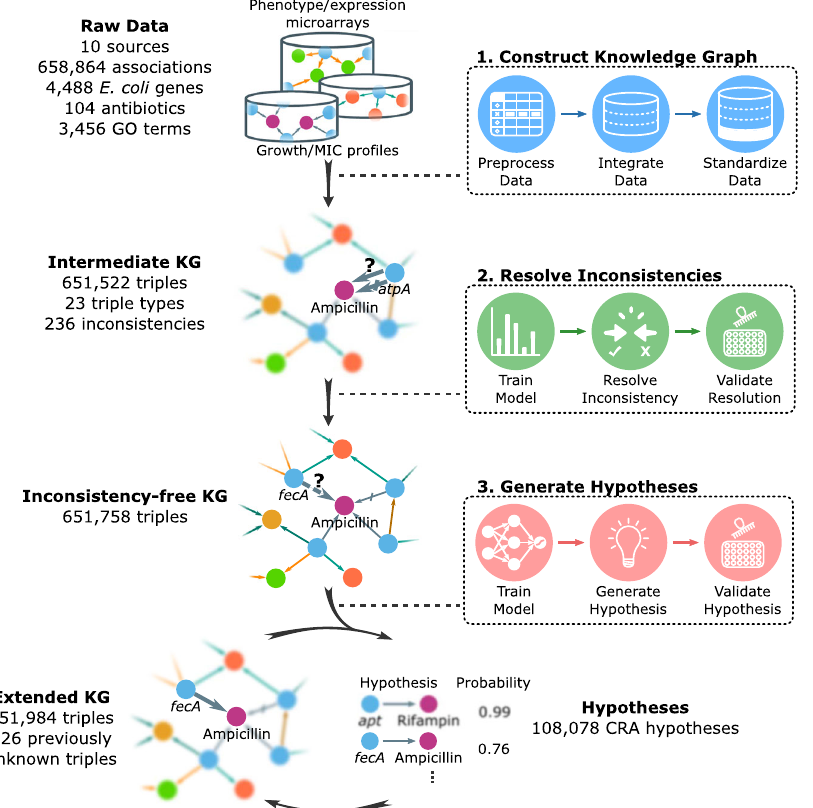
Fig. 1 Overview of the KIDS framework. First, an intermediate knowledge graph is created from ten sources by processing RDF triples that encode 23 types of associations. Second, inconsistencies are computationally resolved and experimentally validated to construct an inconsistency-free knowledge graph. Third, a hypothesis generator is trained on the knowledge graph and assigns probabilities for the missing links. Hypotheses with high probability are experimentally validated, and the results are integrated into the knowledge graph, which is used for the next iteration of hypothesis generation. GO refers to the Gene Ontology, and gray arrows denote the positive predicate ‘ confers resistance to antibiotic (CRA) ’